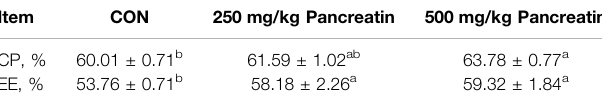
TABLE 4 | Effect of pancreatin on the apparent digestibility of